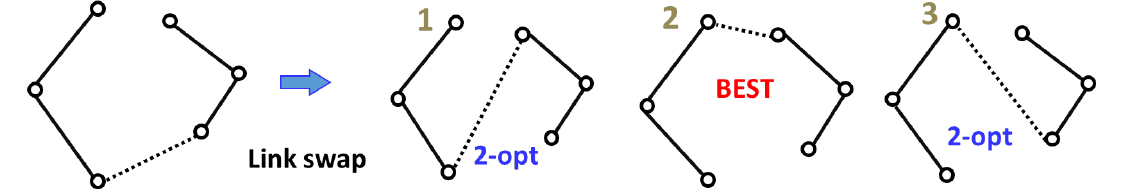
Figure 11. Three neighboring solutions created by link swap, of which the one connecting the terminal nodes is unique.